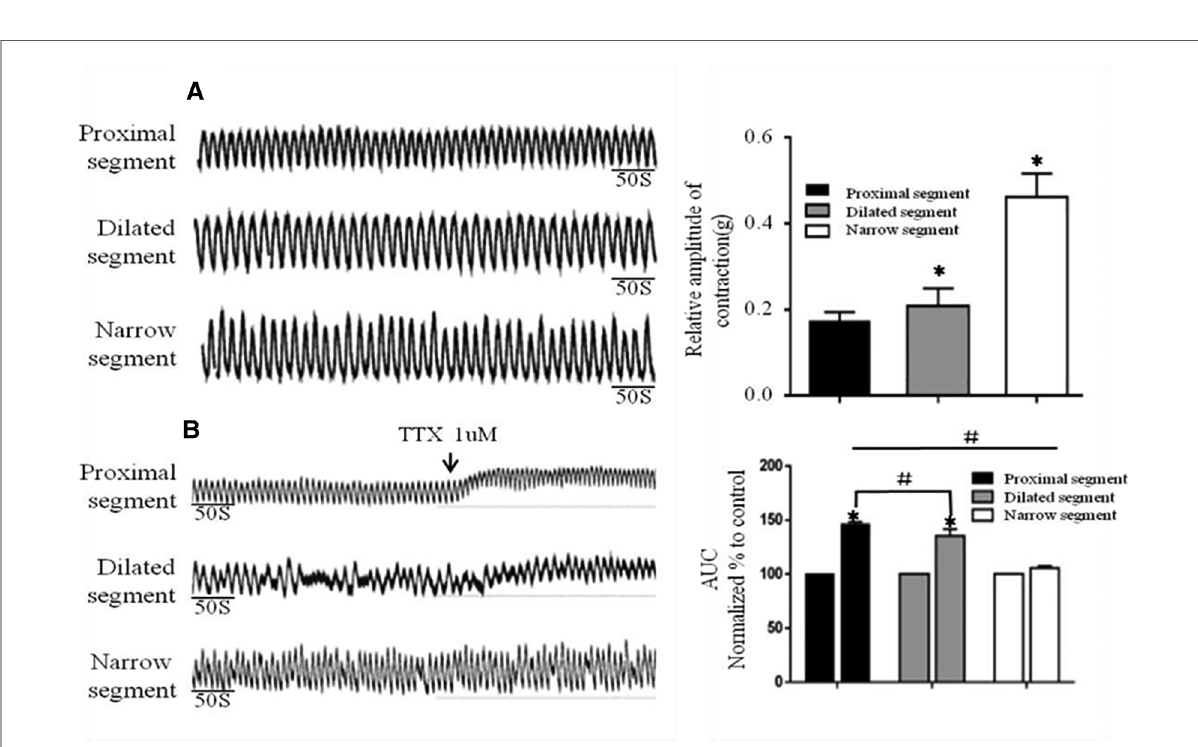
FIGURE 3 Spontaneous contractions of the smooth muscle of the colon without and with TTX blocker. ( A ): Signi fi cant differences among the spontaneous contractions in the narrow segment under static station with no intervention. * P < .05 vs proximal segment. ( B ): AUC alternation of each segment after the addition of the TTX blocker. * P < .05 vs before TTX; # P < .05 vs proximal